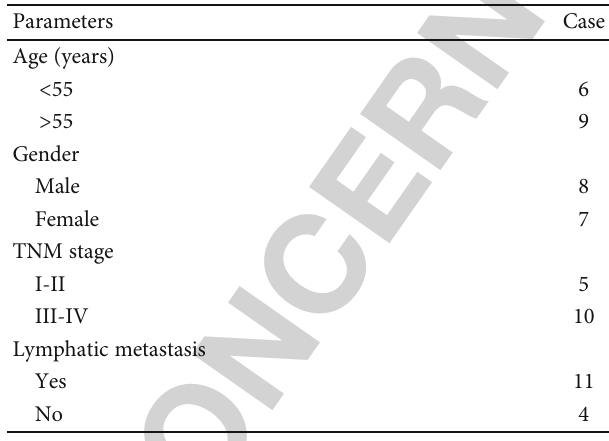
The clinicopathological characteristics in hepatocarcinoma